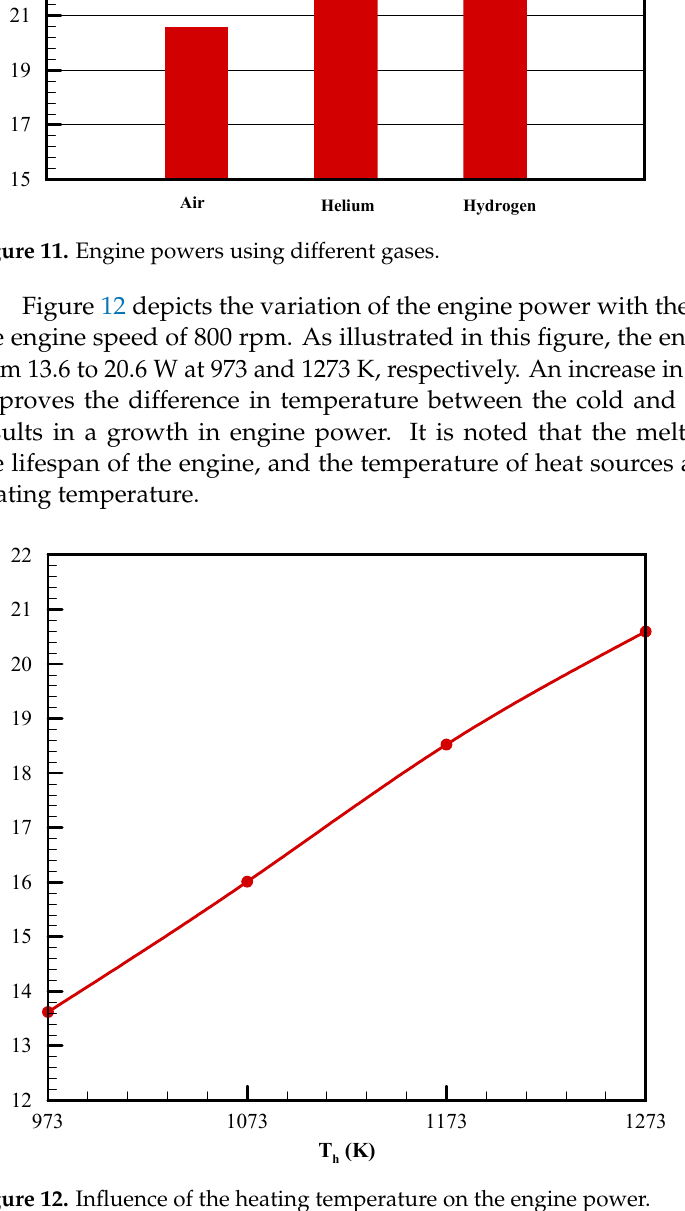
Figure 12. Influence of the heating temperature on the engine power.